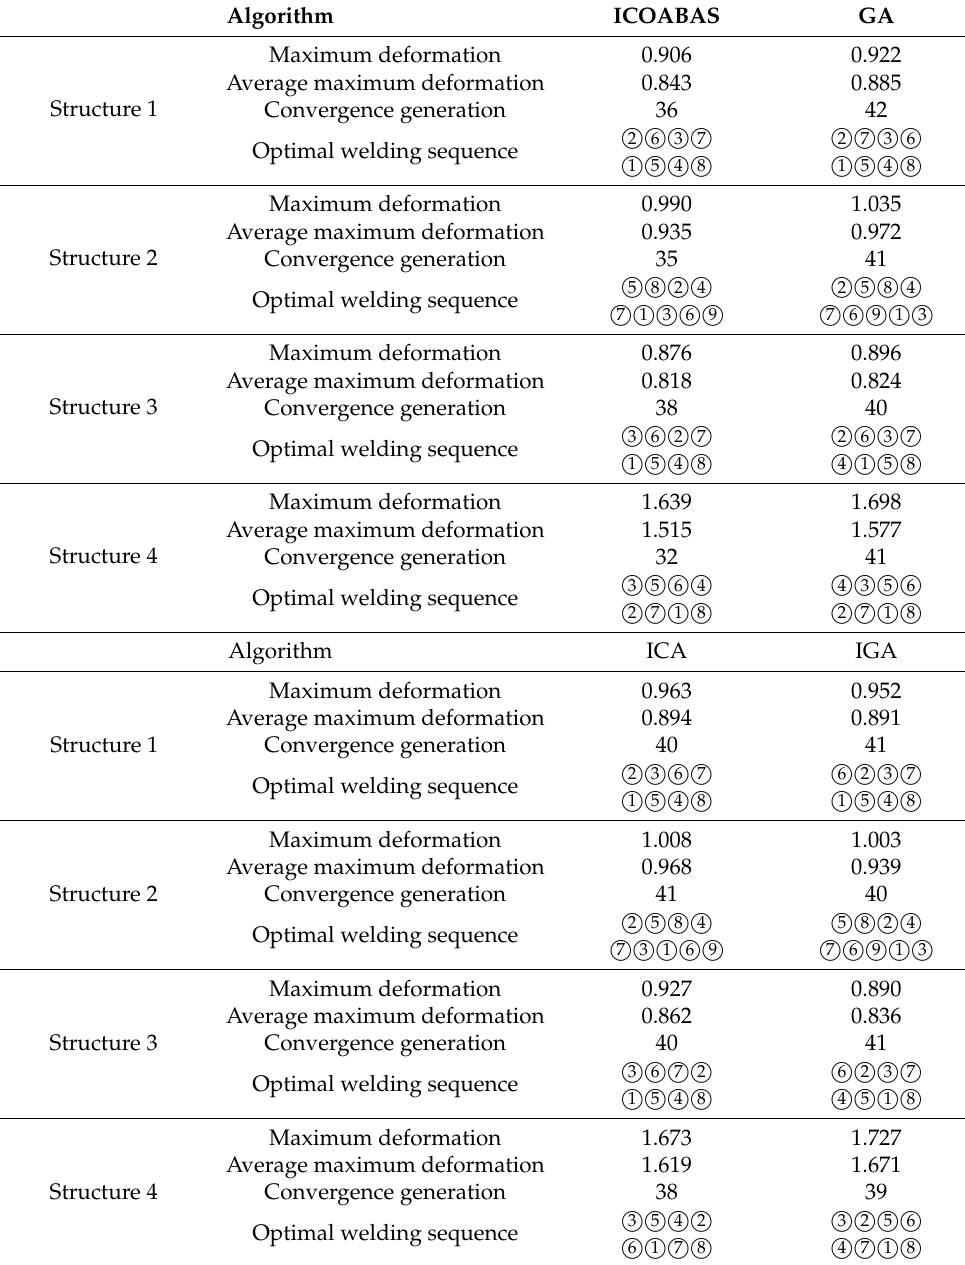
Table 3. Test results of four optimization algorithms on four welded